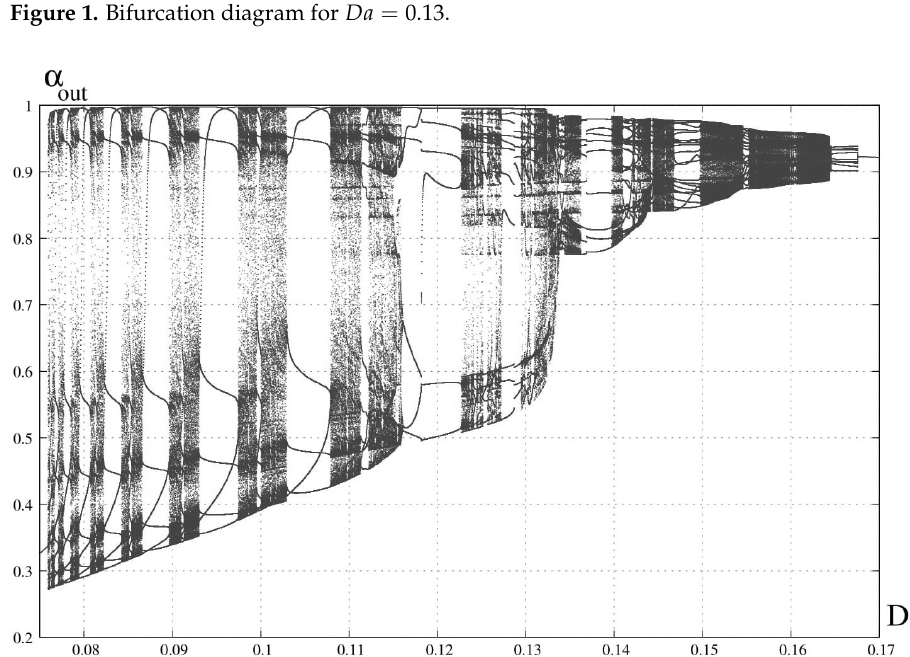
Figure 2. Bifurcation diagram for τ r =